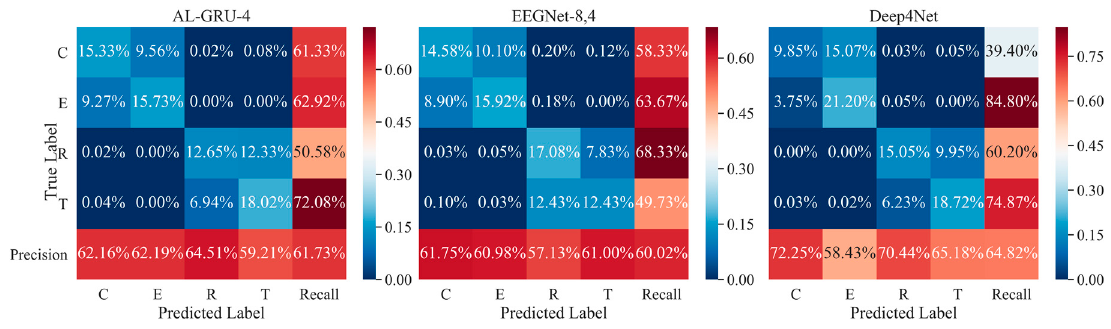
Figure 5. Confusion matrices of AL-GRU and benchmark models. The color scale reveals the classification accuracies. AL-GRU-4 stands for four-layer stacked AL-GRU with skip connections.